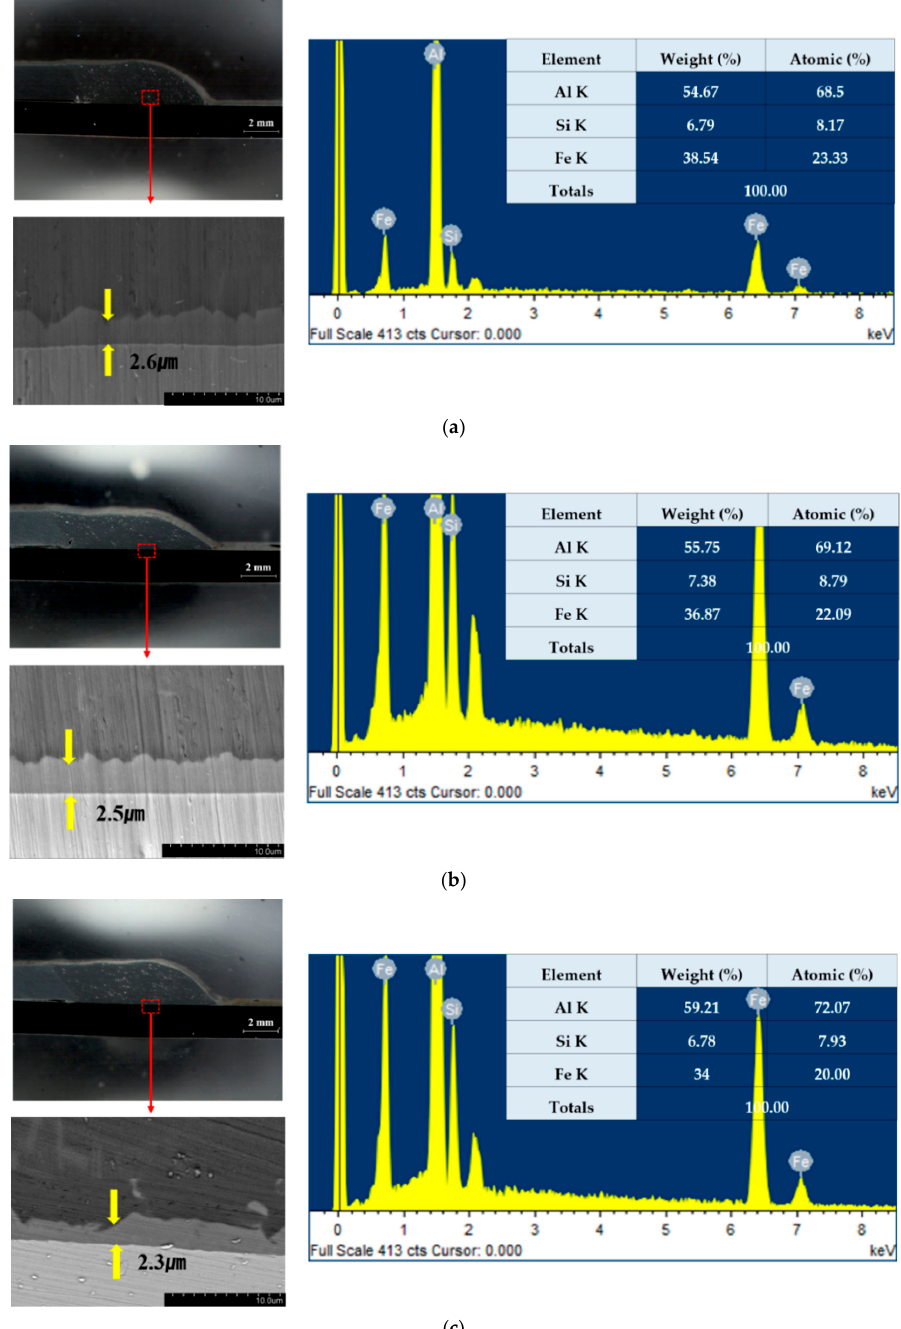
Figure 8. SEM-EDS results of dissimilar braze-welded joints at joint interface: ( a ) 0%, ( b ) 10%, and ( c ) 20%. Dong et al. reported that the IMC layer thickness using the Al-12% Si filler wire re- duced 2.5 times more than that of the Al-5% Si filler wire. Murakami et al. explained the